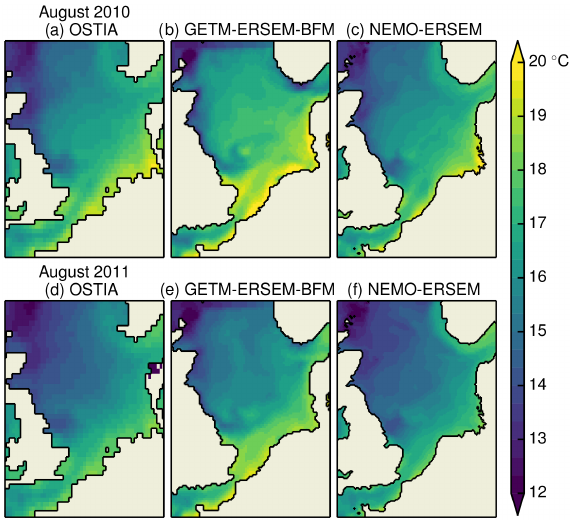
Figure 5. Maps of monthly mean SST for August 2010 (a–c) and August 2011 (d–f) : observational data (a, d) , GETM-ERSEM- BFM (b, e) , and NEMO-ERSEM (c, f) .